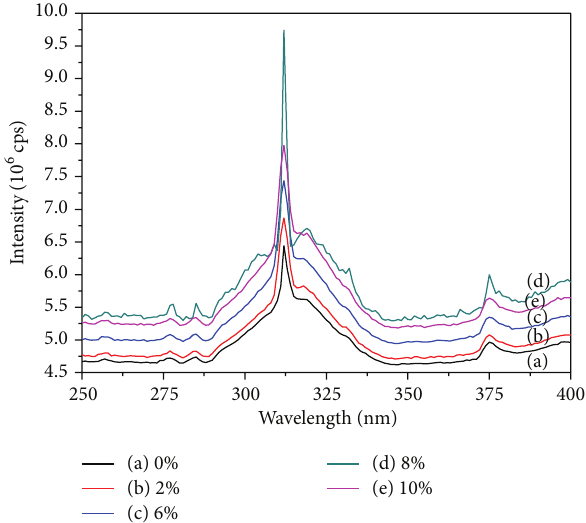
Figure 2: Emission spectra of Pr:Y 2 SiO 5 doped different concentra- tions of Li(I). (a) 0%; (b) 2%; (c) 6%; (d) 8%; (e) 10%.